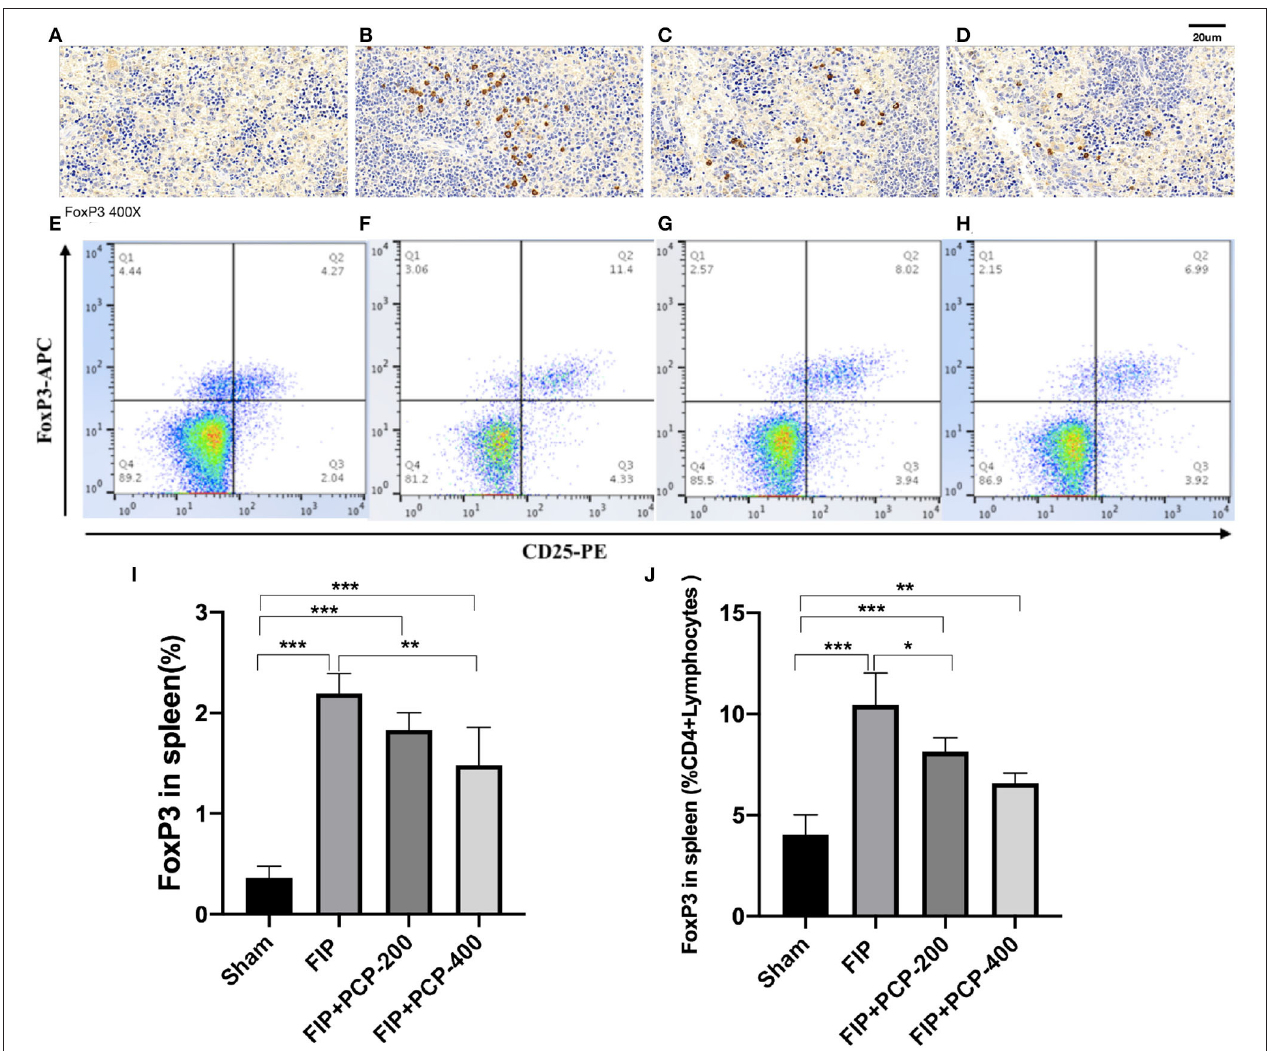
FIGURE 6 | The impact of PCP on Treg cells in the fecal peritonitis-induced septic spleen. PCP pretreatment contributed to decreased FoxP3 labeled cells and CD25 + FoxP3 + cells. (A–D) Immunohistochemical analysis. (E–H) Flow cytometry analysis. (A,E) Sham. (B,F) FIP. (C,G) FIP + PCP-200. (D,H) FIP + PCP-400. (I) Treg cells in the spleen. (J) FoxP3 positive cells in the spleen CD4 + cells. * P < 0.05; ** P < 0.01, *** P < 0.001, FIP + PCP-200 = FIP with PCP 200 mg/kg PCP; FIP + PCP-400 = FIP with PCP 400 mg/kg. All presented data are a composite of three independent experiments. n = 5 in each